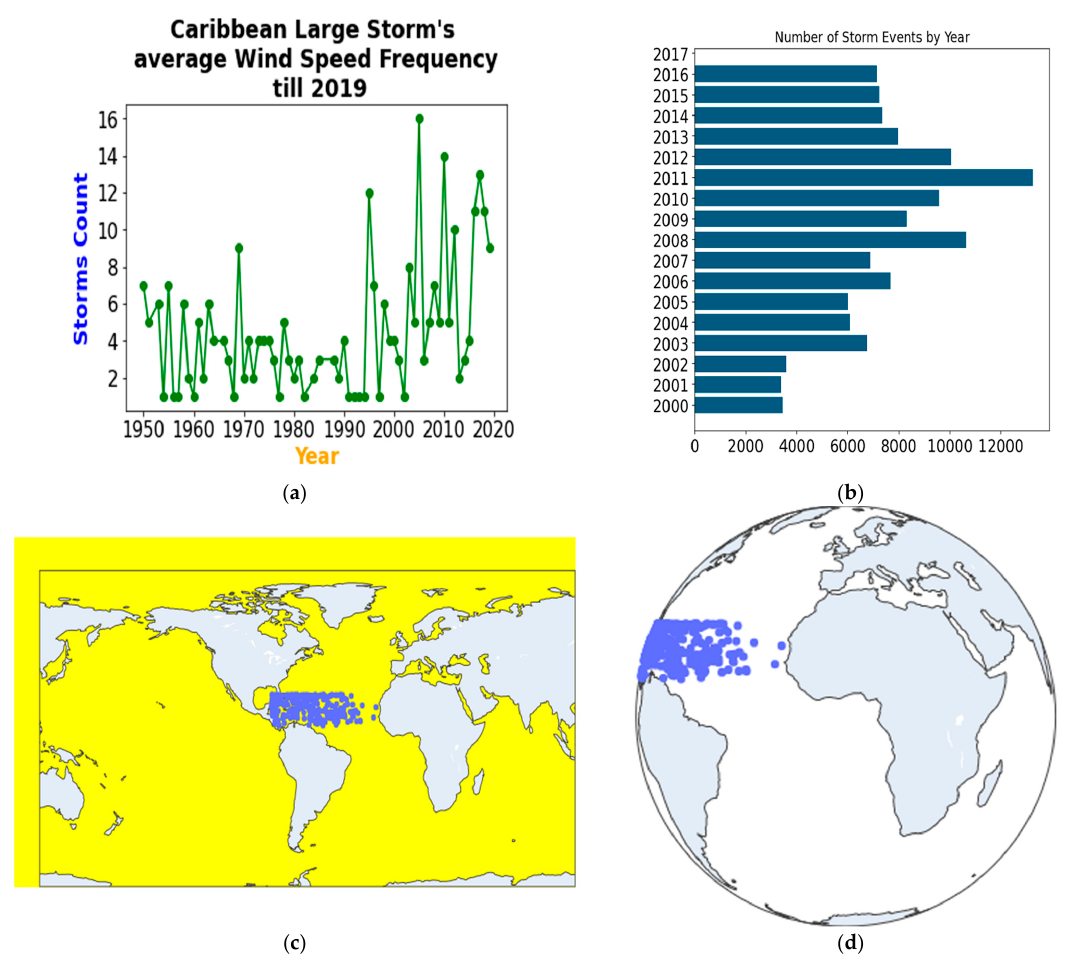
Figure 1. ( a ) Wind speed frequency; ( b ) storm events year-wise; ( c ) enlarged version of map; ( d ) occurrence of large storm.